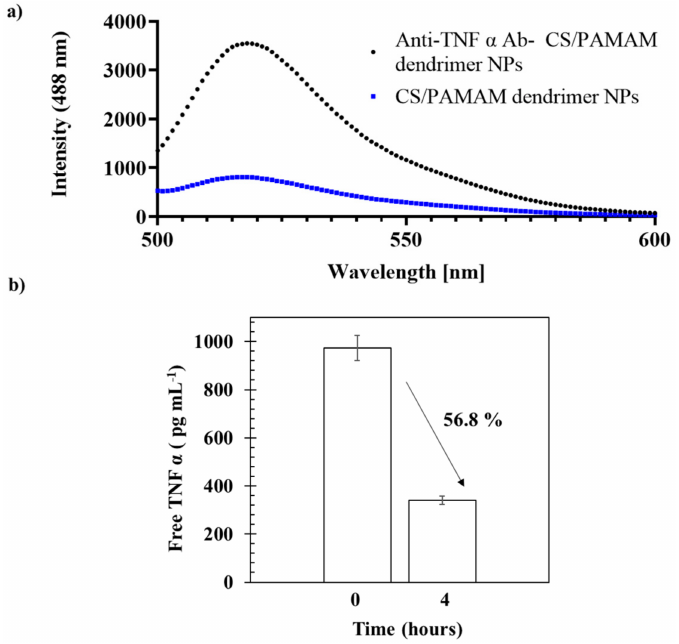
Figure 1. Anti-TNF α antibody conjugation to CS/PAMAM dendrimer NPs. ( a ) Fluorescence spectroscopy of CS/PAMAM dendrimer NPs and anti-TNF α Ab-CS/PAMAM dendrimer NPs. ( b ) Percentage of TNF α captured by anti-TNF α Ab-CS/PAMAM dendrimer NPs. Data shown as Mean ±